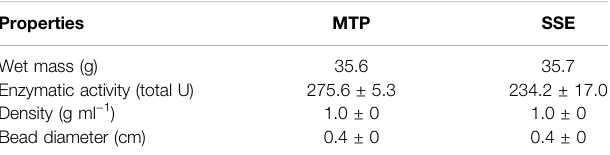
TABLE1| PropertiesoftheCa-alginatederivativeusedinPBRforthetreatmentof the ef fl uents MTP and SSE.